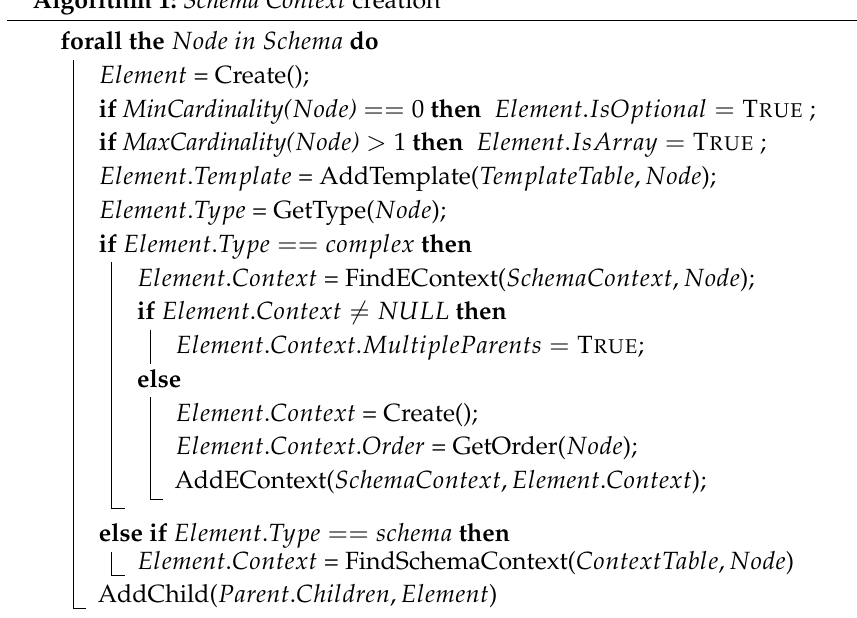
Algorithm 1: Schema Context creation forall the Node in Schema